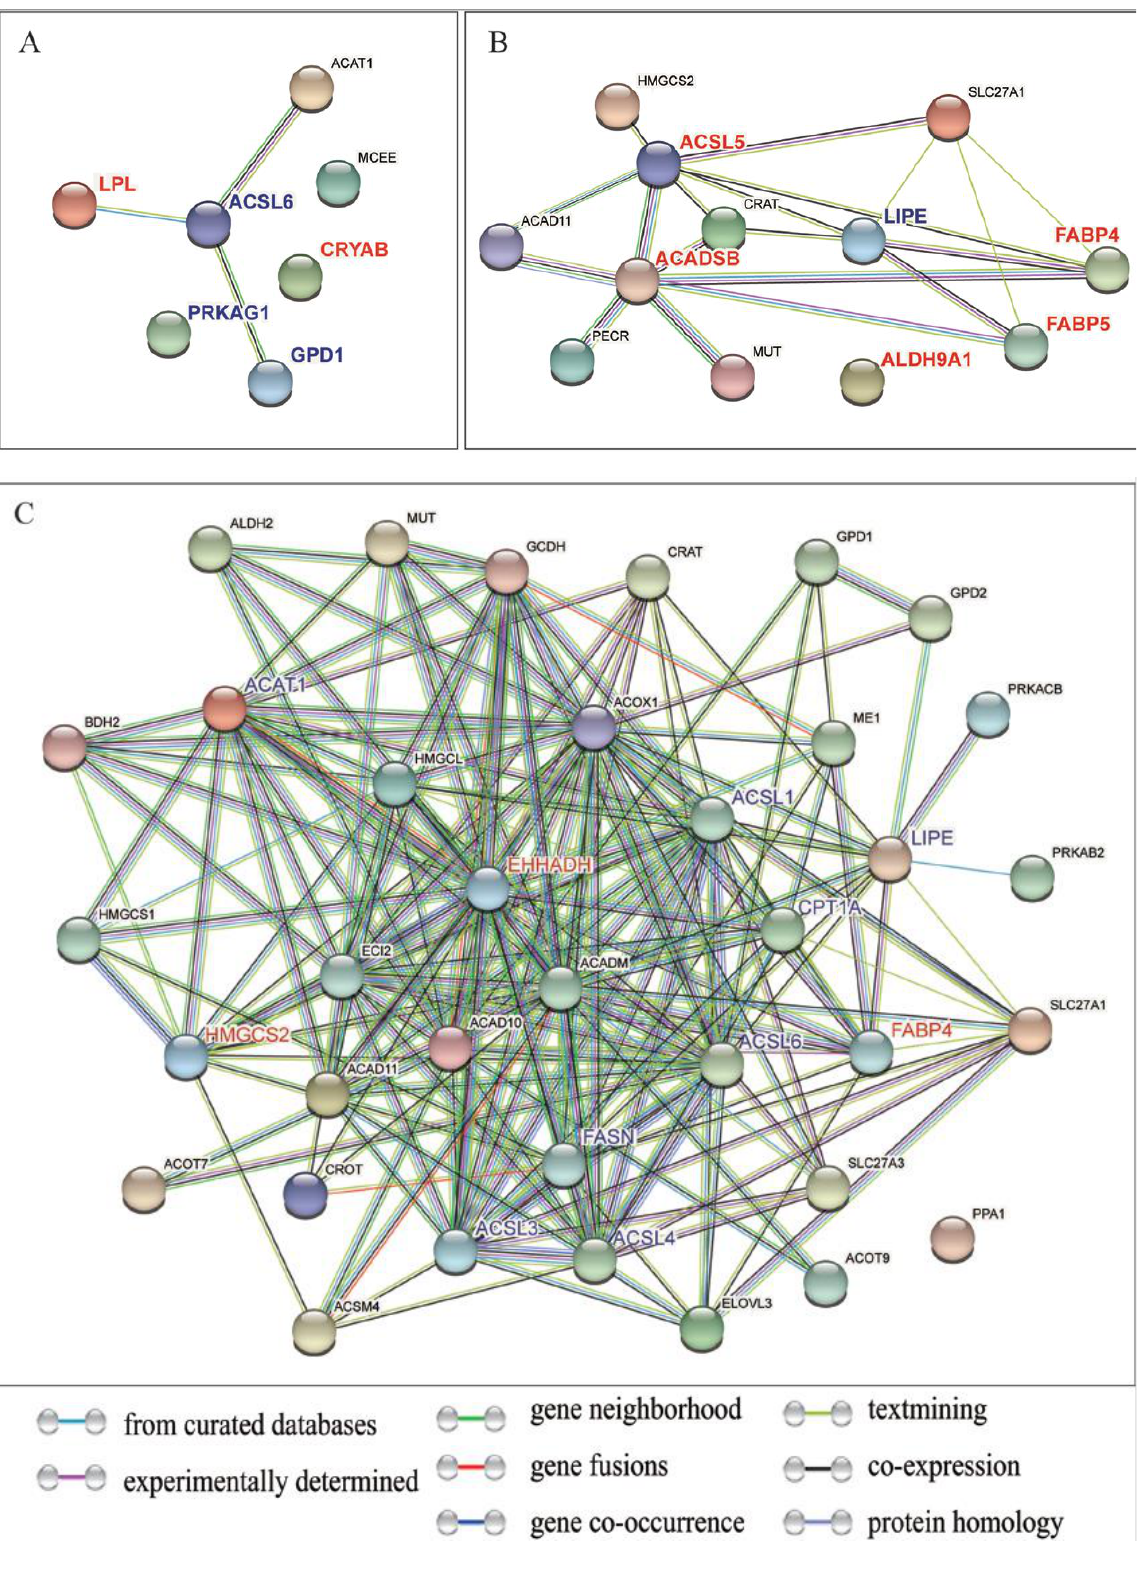
Figure 6. Prediction of protein interaction between genes related to fat and fatty acid metabolism and candidate genes. ( A ) CRYAB and fatty acid metabolic pathway protein interaction network; ( B ) ALDH9A1 and fatty acid metabolic pathway protein interaction network; ( C ) EHHADH and fatty acid metabolic pathway protein interaction